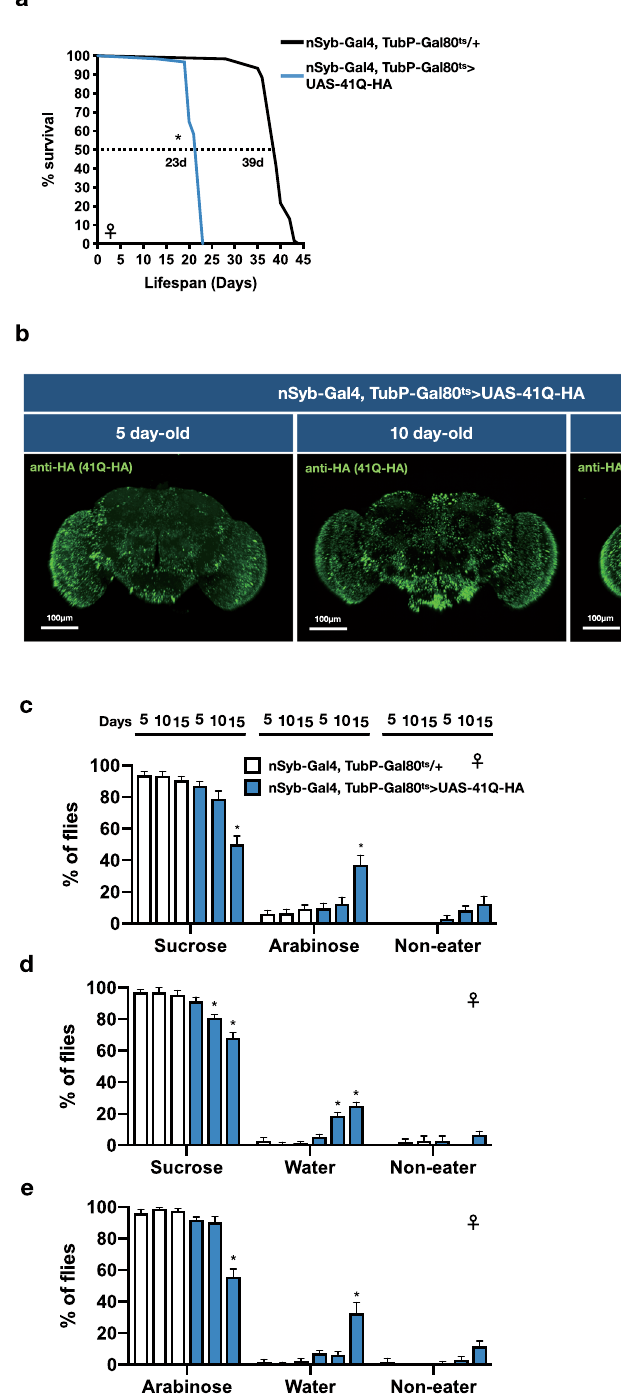
Fig. 3 The ef fi cacy of making proper VBFD is impaired in the polyQ-expressing fl ies. a Survival curves of fl ies with adult-onset ectopic expression of 41Q-HA in the nervous system. Results were analyzed by the log-rank test. n = 60 for each condition. * p < 0.01. b Brain images of female fl ies expressing 41Q-HA for 5, 10, and 15 days. Brain samples were stained with anti-HA (green, stained for 41Q-HA). Scale bars, 100 μ m. The volume of 41Q-HA aggregates was quanti fi ed as described in the “ Methods ” . c – e VBFD assays were performed in female fl ies of different chronological ages (5, 10, and 15 days). The food choices used were 150 mM sucrose and 150 mM arabinose in ( c ); 150 mM sucrose and plain water in ( d ); 150 mM arabinose and plain water in ( e ). Results were expressed as means ± SEM and analyzed by two-way ANOVA. The statistical signi fi cance was assessed by the comparison to age-matched controls. n = 100 for each condition. * p < 0.01. Genotypes: control (TubP- Gal80 ts / + ; nSyb-Gal4/ + ); 41Q-HA-expressing fl ies (TubP-Gal80 ts / + ; nSyb-Gal4/UAS-41Q-HA). The above fl ies were developed at 18 °C and transferred to 29 °C right after eclosion. VBFD assays were performed at 29